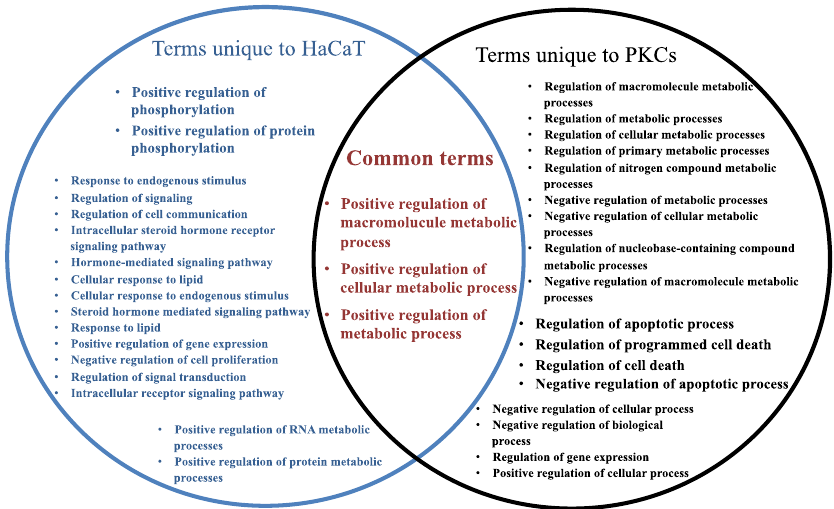
Figure 5. Common and unique terms associated with HaCaT- and PKC-derived EVs. The reported terms herein are from the 20 most statistically significant GO Terms. The red text indicates common terms associated with the target genes of miRNA from HaCaT- and PKC-derived EVs.